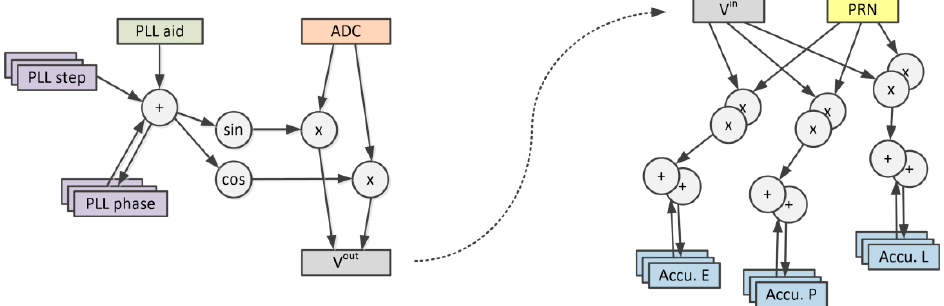
Figure 5. Extracting two instruction templates from DAG graph.